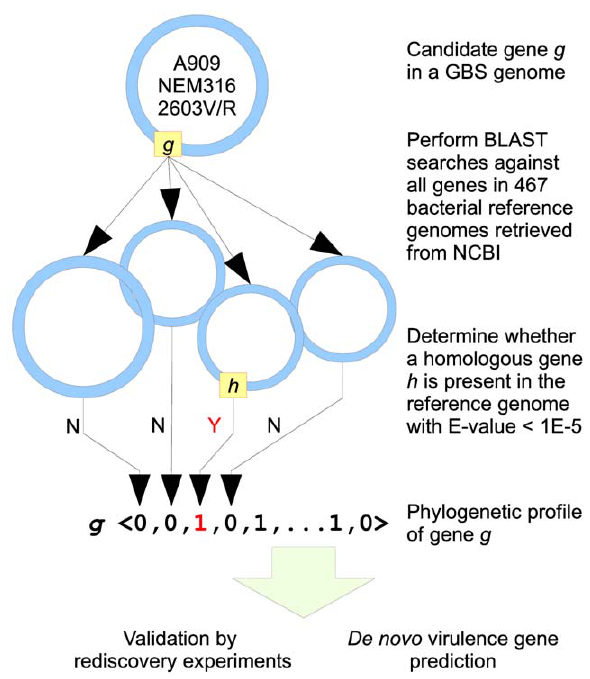
Figure 1. Determination of phylogenetic profiles. For each gene, a candidate-against-all BLAST was performed to determine whether at least one homolog of a candidate gene is present in a given reference genome. The binary values of presence (1) or absence (0) were stored in a vector which were used for subsequent rediscovery analyses and virulence gene